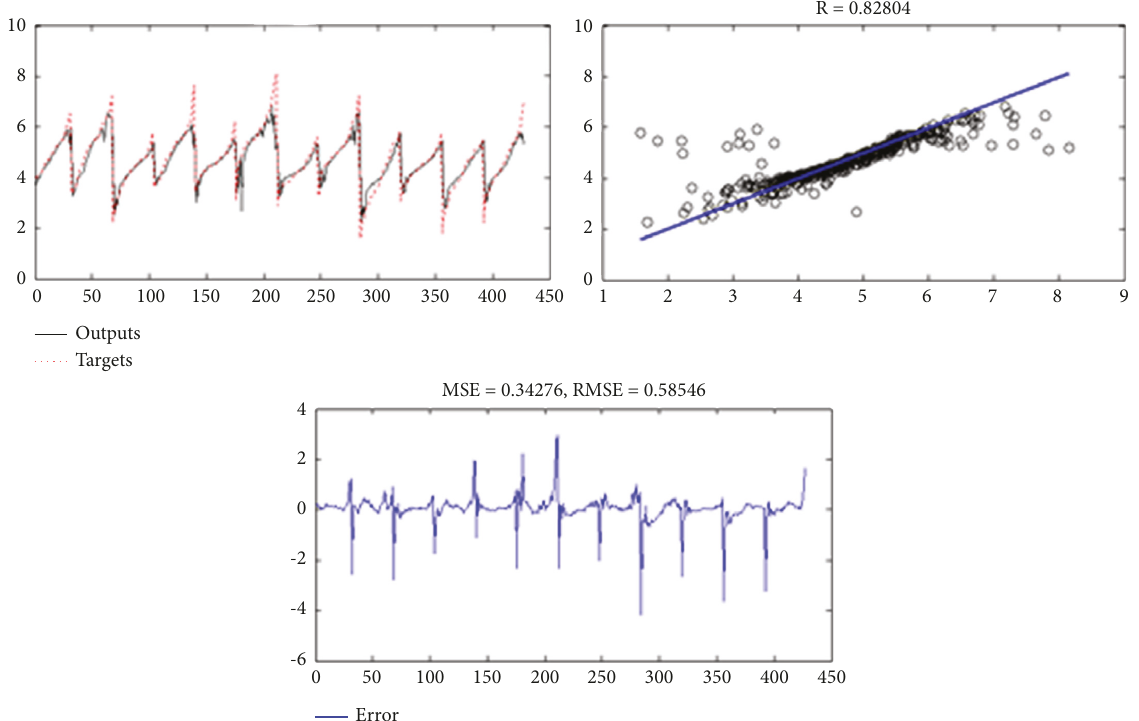
Figure 4: Diagram of forecasted demand and expected demand of the neural